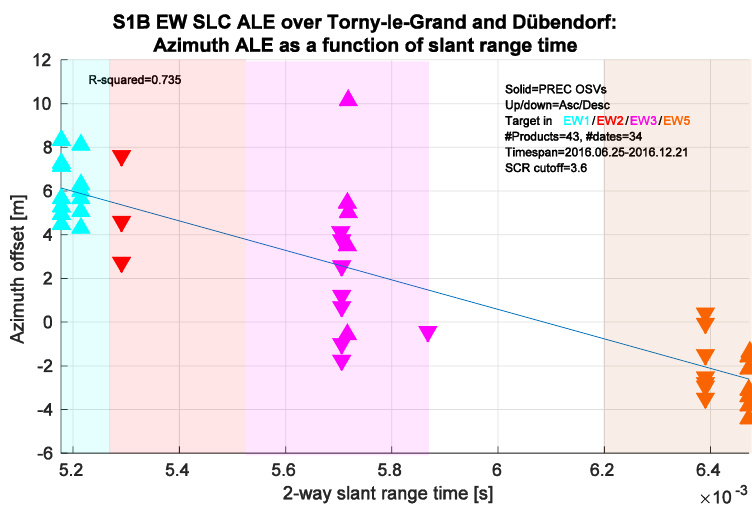
Figure 5. S-1B EW mode SLC geolocation accuracy based on products over Swiss test sites in 2016: ( a ) S-1B (no S-1A products available); ( b ) azimuth error vs. slant range time for EW mode SLC products, with least-squares fit. Coloured regions indicate approximate subswath ranges (except EW4).